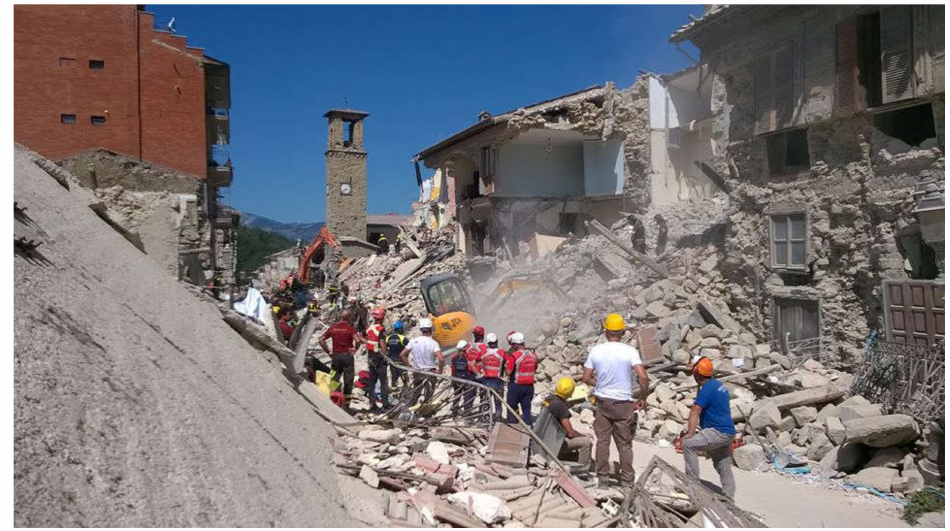
Figure 7. Salvage operation after the earthquake of August 2016, which destroyed the historic center of Amatrice. After one year, rubble is still on the streets. Photograph: Roberto